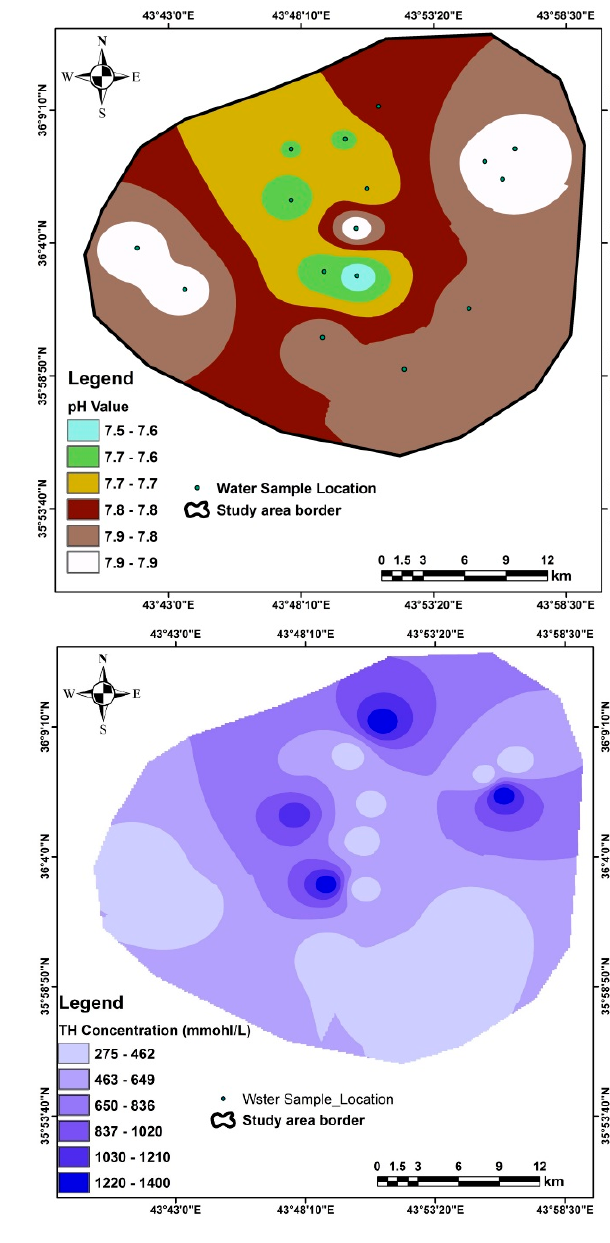
Figure A1. Special distribution of some physiochemical parameter in the study area.